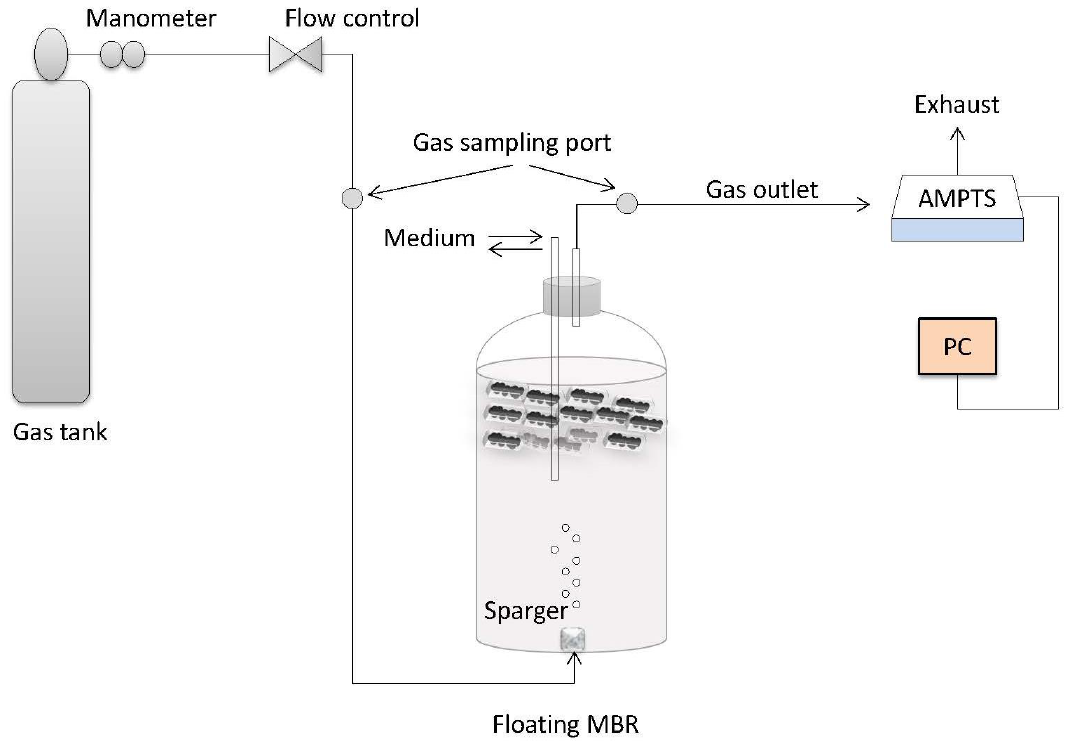
Figure 1. Schematic of gas and liquid feeding in the floating MBR (membrane bioreactor).